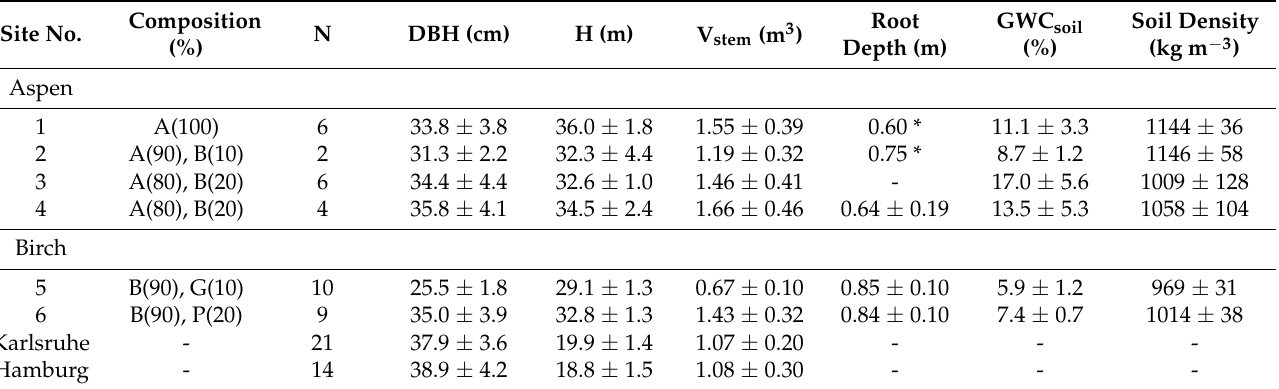
Table 1. Tree species composition (proportion from the standing volume), the number of sampled trees (Tree N) mean ( ± 95% confidence interval) diameter at breast height (DBH), height (H), stem– wood volume (V stem ), root depth of uprooted sample trees, and gravimetric water content (GWC soil ) and density of soil of each sampled site. Tree species abbreviated as follows: A—common aspen ( Populus tremula L.); B—birch ( Betula pendula Roth.), G—gray alder ( Alnus incana (L.) Moench.); P—Scots pine ( Pinus sylvestris